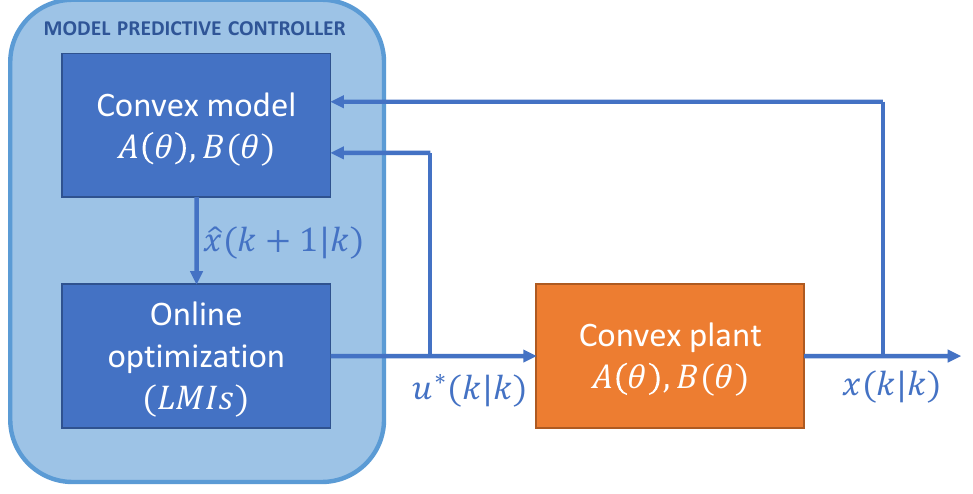
Figure 4. Convex model predictive control